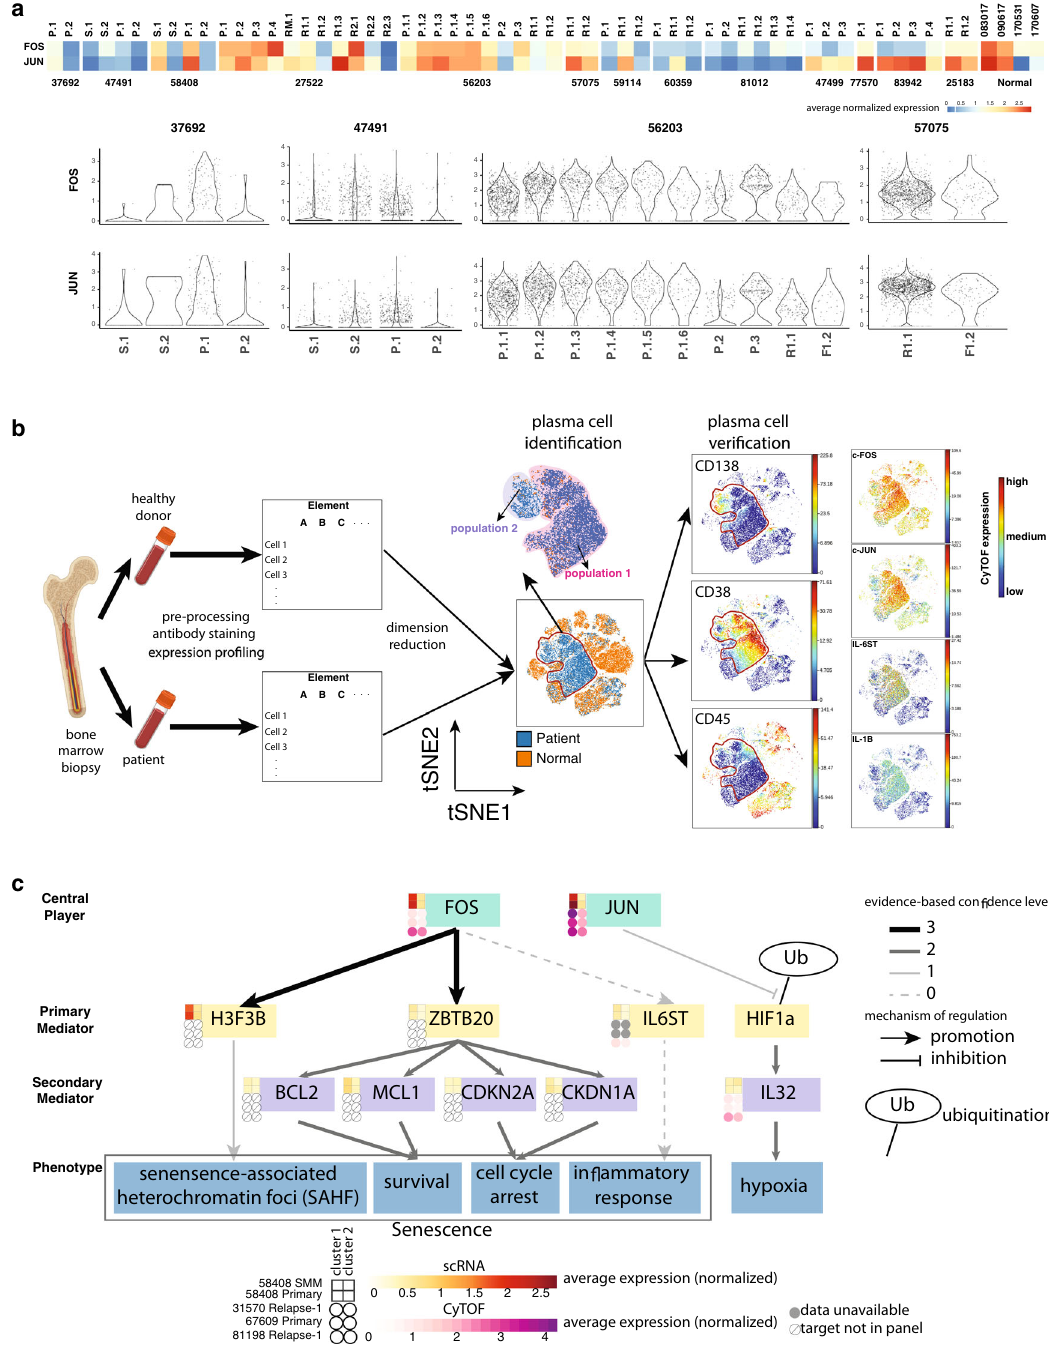
Fig. 7 AP-1 expression population in plasma cells con fi rmed by independent cohort. a AP-1 components expression across plasma cell subpopulations across samples. Upper: average expression for FOS and JUN for each subpopulation. Lower: violin plot showing the expression patterns of FOS and JUN for some cases of interest. S SMM, P Primary, RM Remission, R1 Relapse-1, R2 Relapse-2. b CyTOF experiment work fl ow and data analysis. Bone marrow samples from patient and healthy donors are preprocessed, stained for target antibodies of interest, and expression is pro fi led in parallel. Samples from patients and healthy donors are merged together and visualized with t-SNE. Regions where only patient samples occupy are further checked for CD138, CD38, and CD45 for veri fi cation of their plasma cell identity. Expression pro fi le for FOS, JUN, IL-1B and IL-6 within plasma cells are shown. c . Proposed mechanism of how AP-1 complex in fl uences the phenotype of myeloma cells. Heatmap beside each gene indicates normalized expression for different populations of plasma cells in Patients 58408 (SMM and Primary), 31570, 67609, and 81198. scRNA-seq expression data, yellow scale; CyTOF expression data, purple scale. Solid arrows indicate the presence of evidence from literature or database. Dashed arrows indicate indirect evidence. Color of solid arrows indicates the con fi dence level of the evidence of origin. 3, evidence from ChIP-seq database; 2, evidence from myeloma associated literature; 1, evidence from non-myeloma associated literature. Clusters 1 and 2 for each case are manually de fi